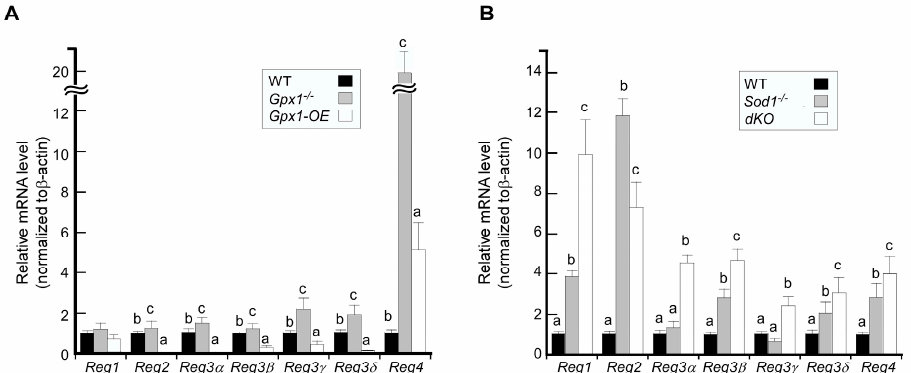
Figure 1. Relative abundance of Reg mRNA in pancreatic islets of wild-type (WT), Gpx1 -/- , and Gpx1-OE mice ( A ), and WT, Sod1 -/- , and Gpx1 -/- Sod1 -/- ( dKO ) mice ( B ). Gene expression was quantified by Q-PCR and normalized with β -actin expression. Values were expressed as relative expression levels to respective WT and presented as mean ± SD. Data were analyzed using one-way analysis of variance (ANOVA) for individual genes. Means of the same gene without sharing a common letter differ at p < 0.05; n = 4–6.